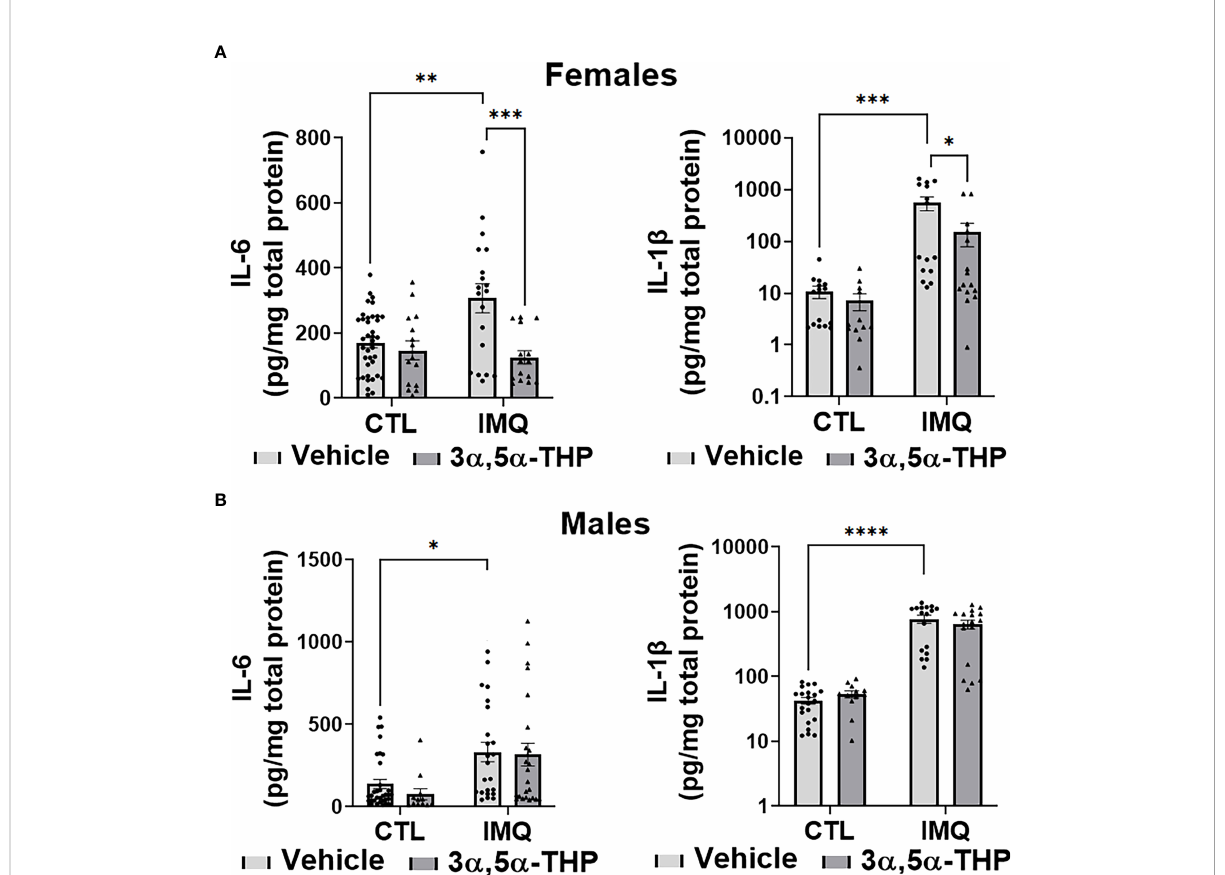
FIGURE 6 Allopregnanolone (3 a ,5 a -THP) inhibits imiquimod-induced increases of in fl ammatory cytokines IL-6 and IL-1 b in human monocyte-derived macrophages (hMDM) from female but not male donors. Each hMDM culture (n ≥ 12 cultures from 3-5 female (A) or 3-5 male (B) donors/grp)